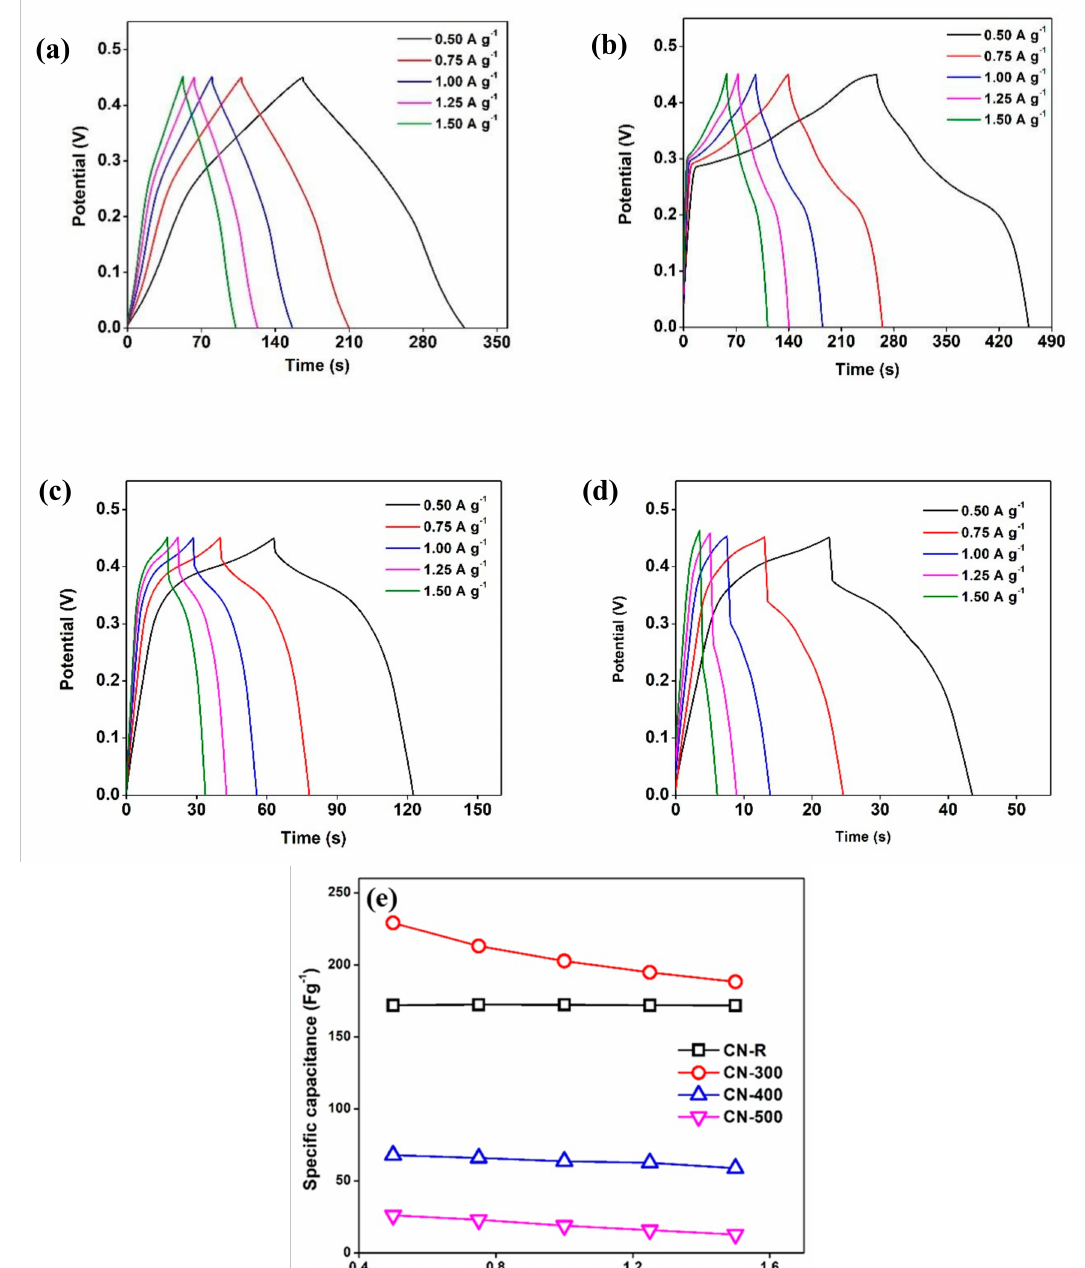
Figure 9. Galvanostatic charge–discharge (GCD) tests of ( a ) CN-R, ( b ) CN-300, ( c ) CN-400, ( d ) CN-500, and ( e ) specific capacitance at various current